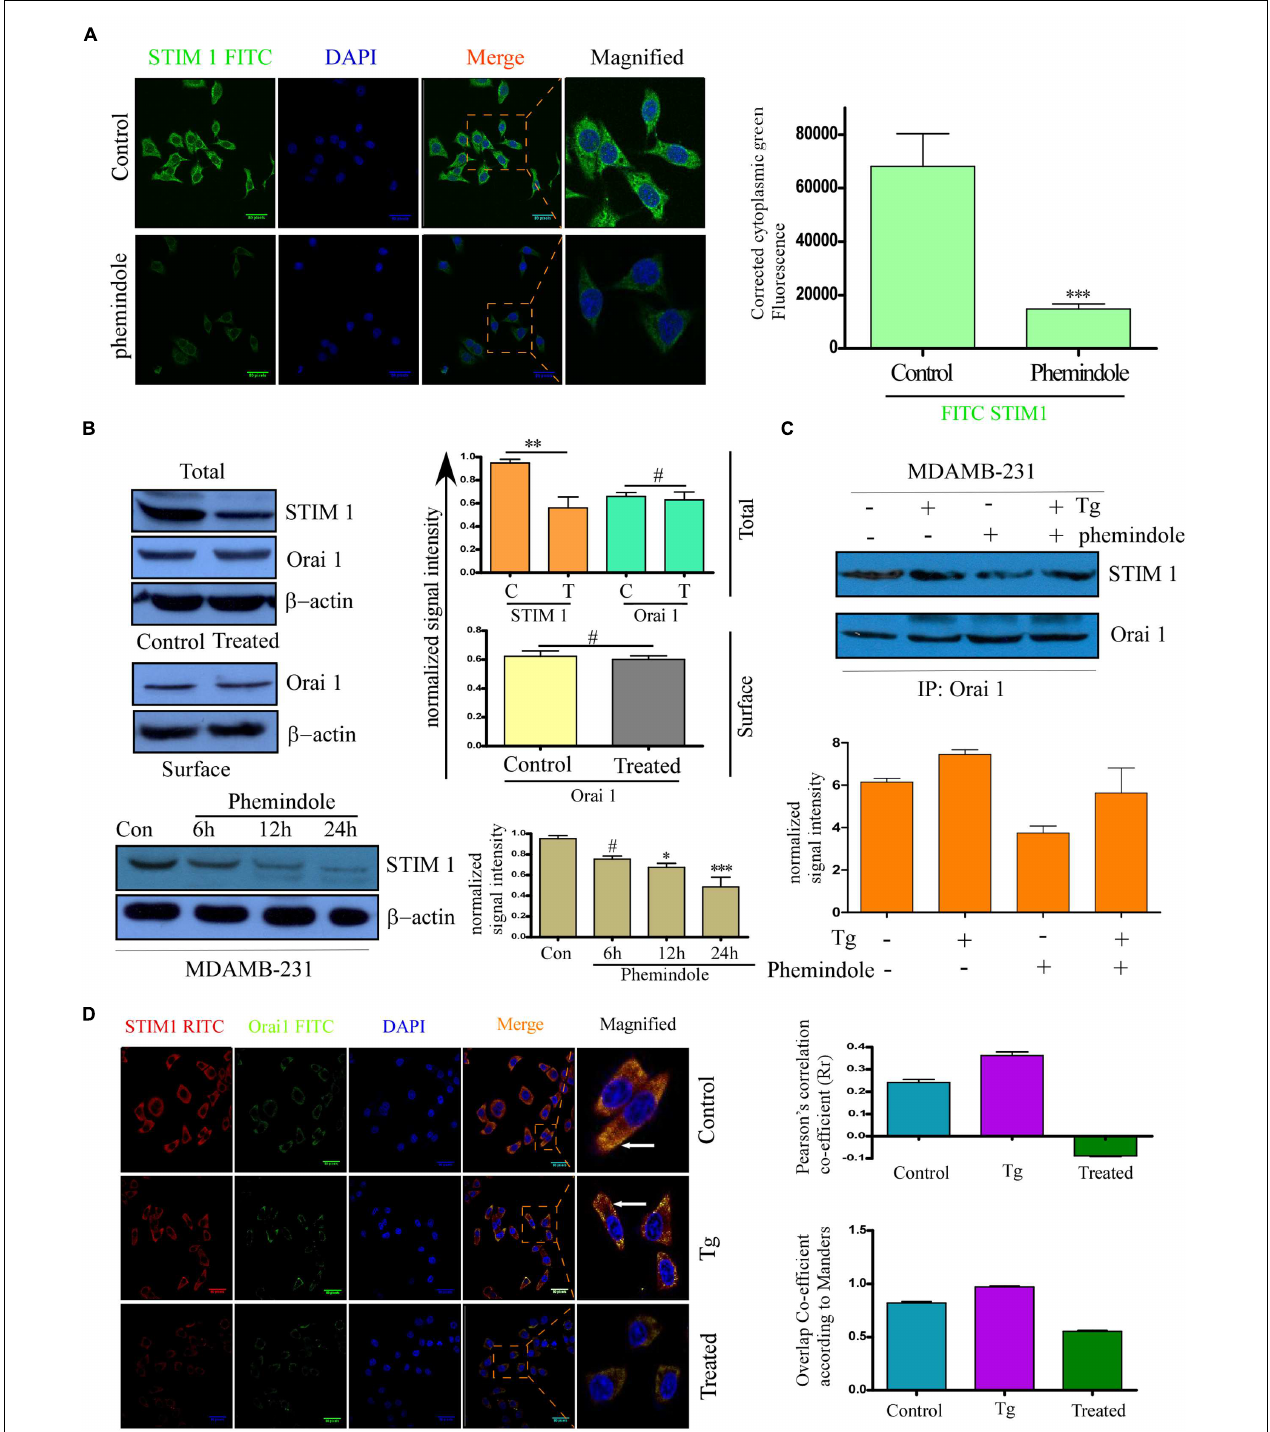
FIGURE 4 | Phemindole downregulates STIM1 Expression. (A) Immunofluorescence images showing decreased expression of STIM1 in the MDAMB-231 cells in response to Phemindole treatment. Anti STIM1 antibody was FITC tagged (green) and nuclei were stained with DAPI (blue) (left panel). Corrected Fluoroscence intensity of STIM1 protein was quantified and represented as bar diagram (Right panel). Pictures showed representative cells of each population and were representative of three independent experiments. (B) Western blot analysis depicting the changes in the expression pattern of STIM1 and Orai1. MDAMB-231 cells were treated with Phemindole and Western blotted with respective antibodies as labeled in the figure (upper-left panel). Quantification of WB were depicted as bar diagram (upper-right panel). MDAMB-231 cells were treated with 10 µ M Phemindole for 24 h. Lysates were subjected to SDS–PAGE followed by Western